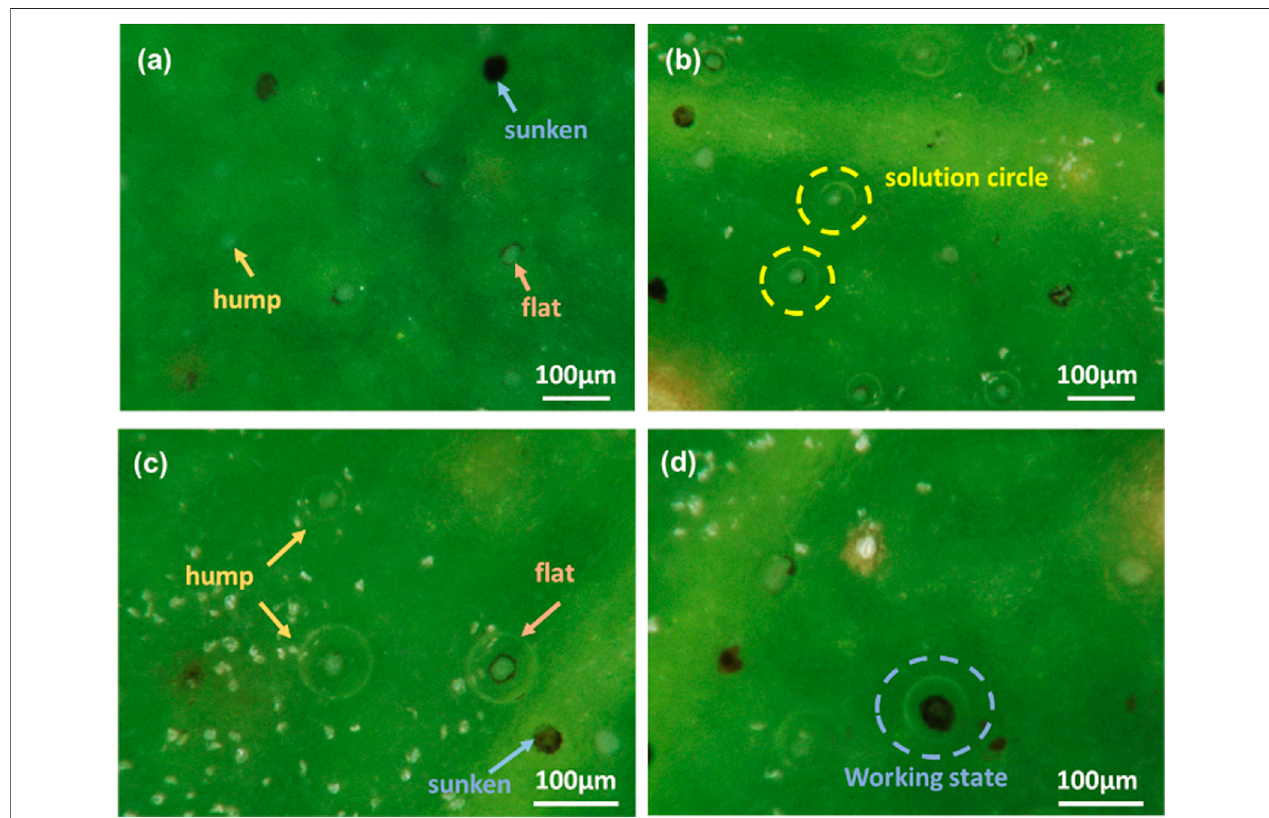
FIGURE 3 | The optical images of mangrove leaves with the three types of salt glands (a) at the beginning of salt secretion and (b – d) after salt secretion.